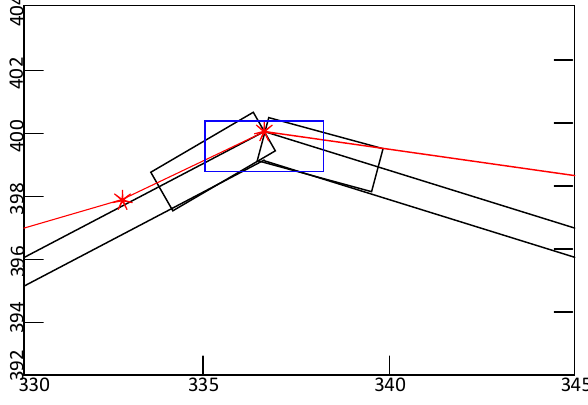
Figure 27. Failure of collision detection.